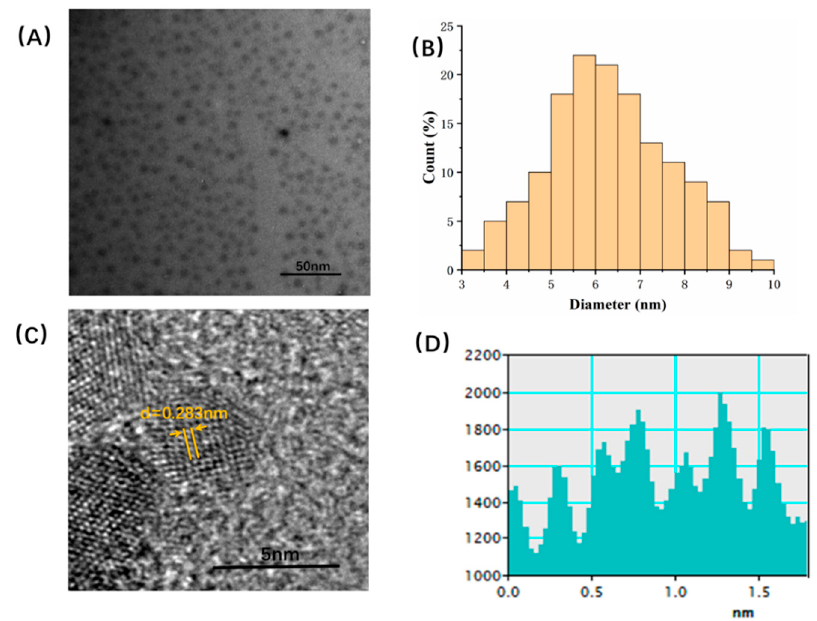
Figure 1. Characterization of Pueraria carbon dots. ( A ) Transmission electron microscopy (TEM) images of Puerariae lobatae Radix carbon dots (PLR-CDs). ( B ) TEM size distribution of PLR-CDs. ( C ) High-resolution TEM (HRTEM) image of PLR-CDs. ( D ) Line profiles of the corresponding HRTEM images of PLR-CDs analyzed on HRTEM.